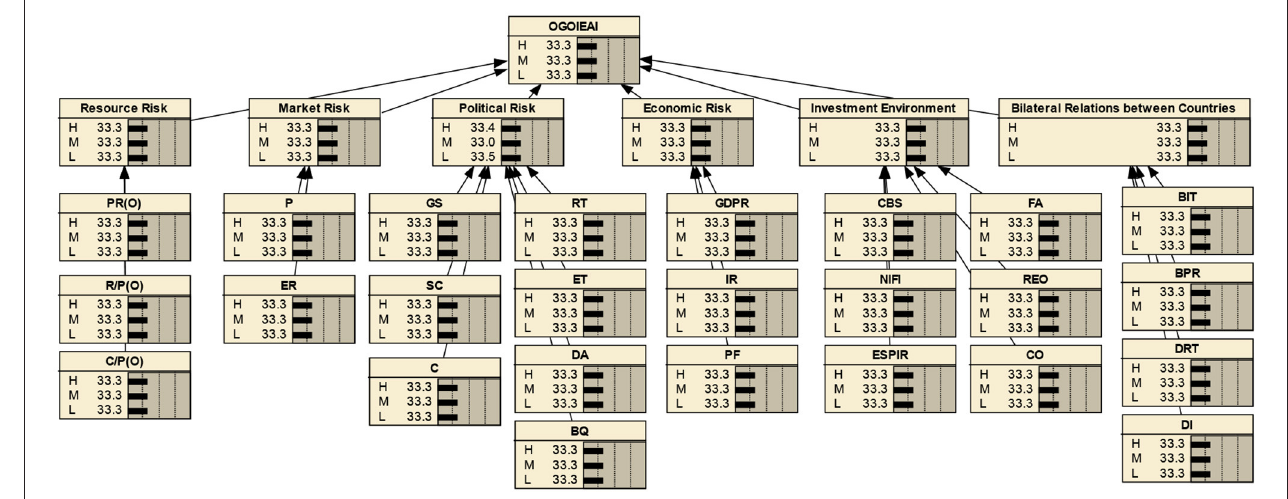
FIGURE 3 | CPBN of oil and gas overseas investment environment risk.